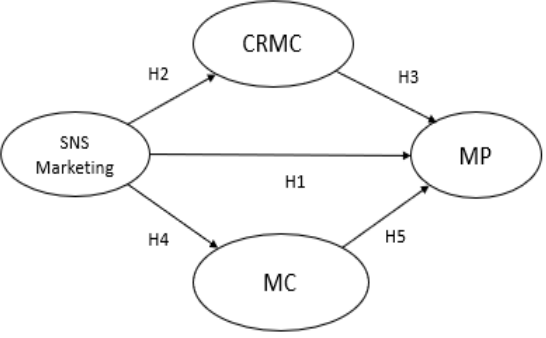
Fig. 1. Research concept